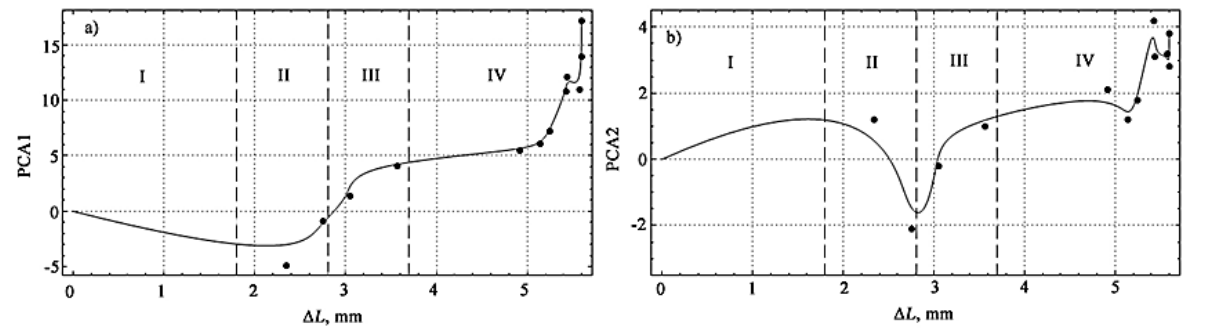
Figure 13. The first ( a ) and second ( b ) principal components as functions of the sample deflection (the dots show the values of the principal components for recorded AE signals, the solid line is the cubic spline approximation).